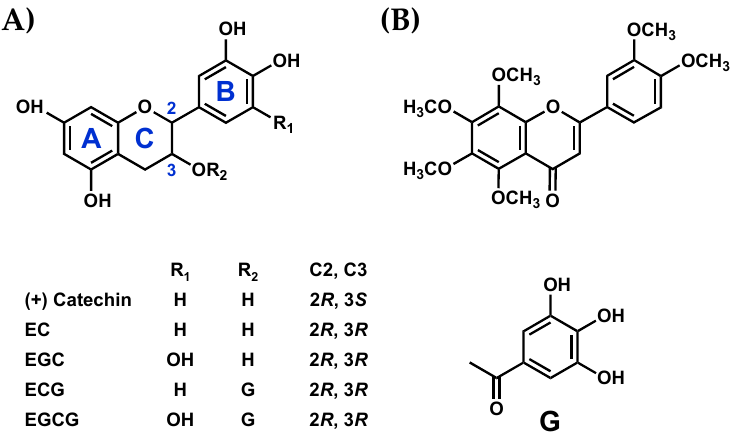
Figure 1. Polyphenols used in this study. ( A ) Structure of catechin. ( B ) Structure of nobiletin. G: galloyl group.